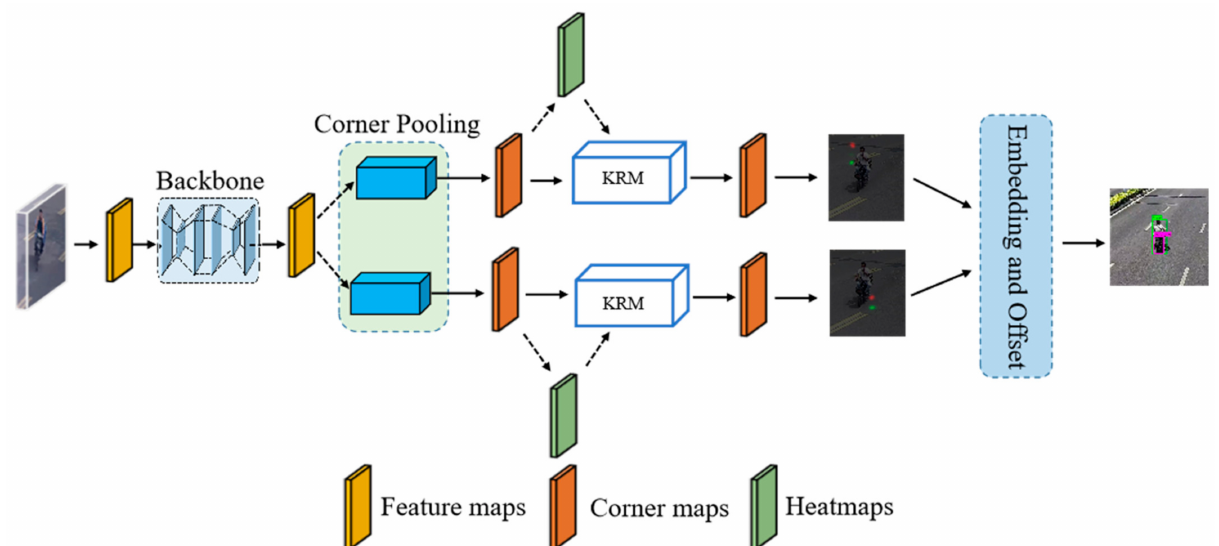
Figure 2. An overview of knowledge-driven networks (KDNet) for object detection. In KDNet, we used a 512 × 512-pixel image as input. Firstly, the input image was downsampled to 64 × 64, and then the features were extracted through the backbone network to generate a feature map with the same dimension as the input. Secondly, the feature map generated a corner map through the independent corner pooling network and generated a heatmap using the corner map as its characteristic angle. Finally, the keypoint relation module (KRM) was used to model the relationship of each keypoint, and then, the keypoints with knowledge fusion were used to reposition the geometric position of the keypoints; thus, we obtained a more accurate